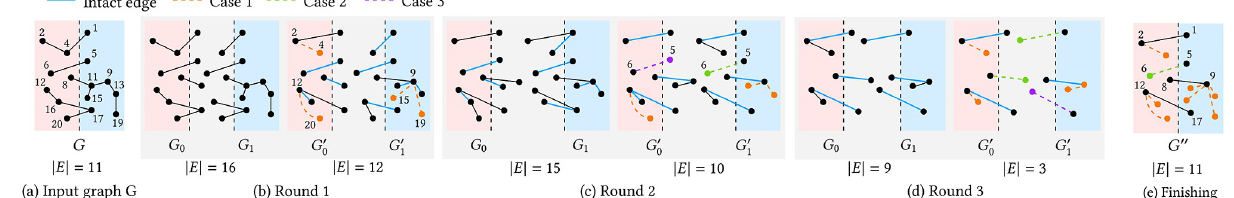
Fig 5. An example of UniStar-opt when the threshold τ = 4. Intact edges are represented as blue lines. The edges filtered by cases 1, 2, and 3 are marked with orange, green, and purple dashed lines, respectively. As the number of remaining edges after round 3 is less than τ = 4, the output edges of Rem on the graph induced by the remaining edges and the edges filtered by cases 1 and 2 become the input of the finishing